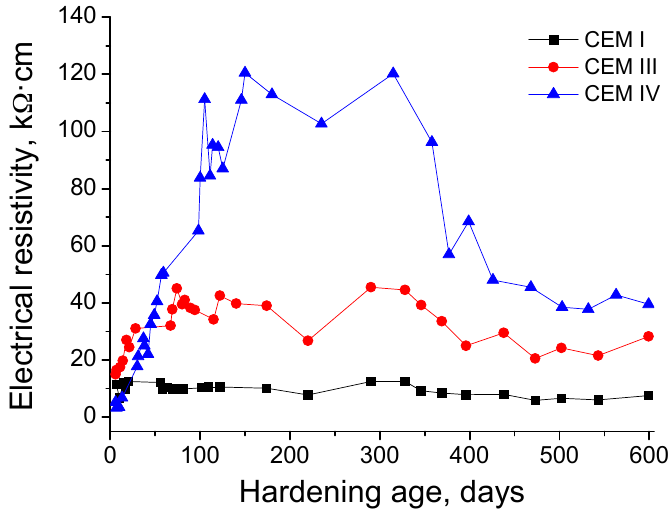
Figure 6. Evolution of electrical resistivity for CEM I, III and IV grouts.